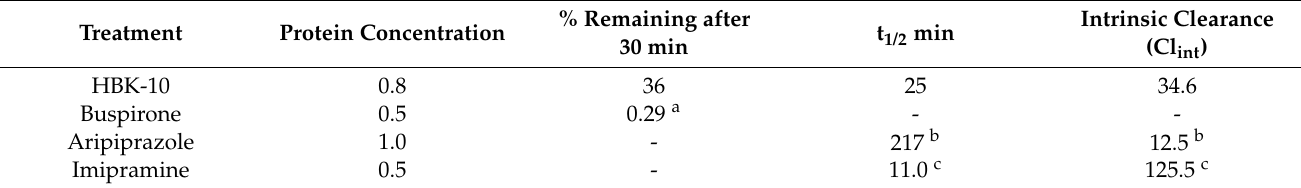
Table 2. Microsomal stability of HBK-10 and the reference drugs estimated in vitro in microsomal model (MLMs).